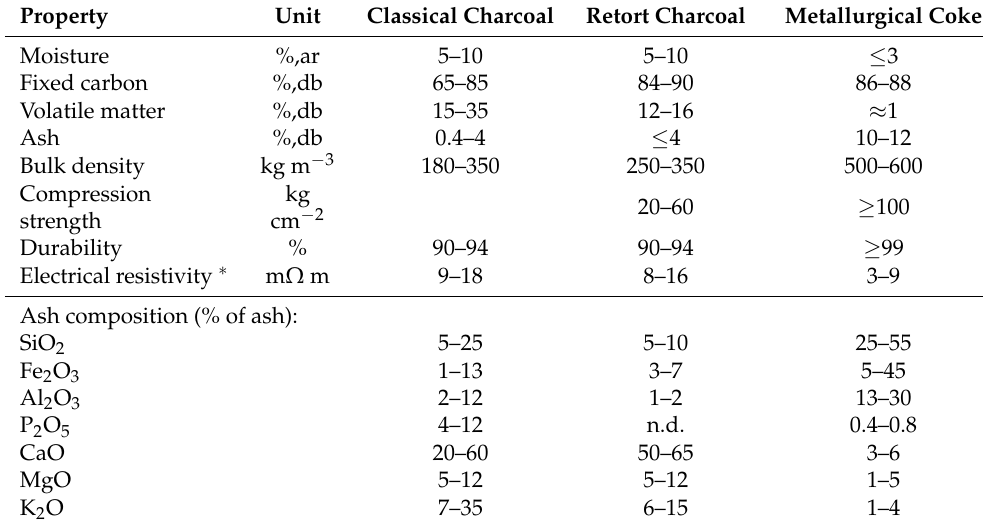
Table 1. Typical properties of charcoal and metallurgical coke